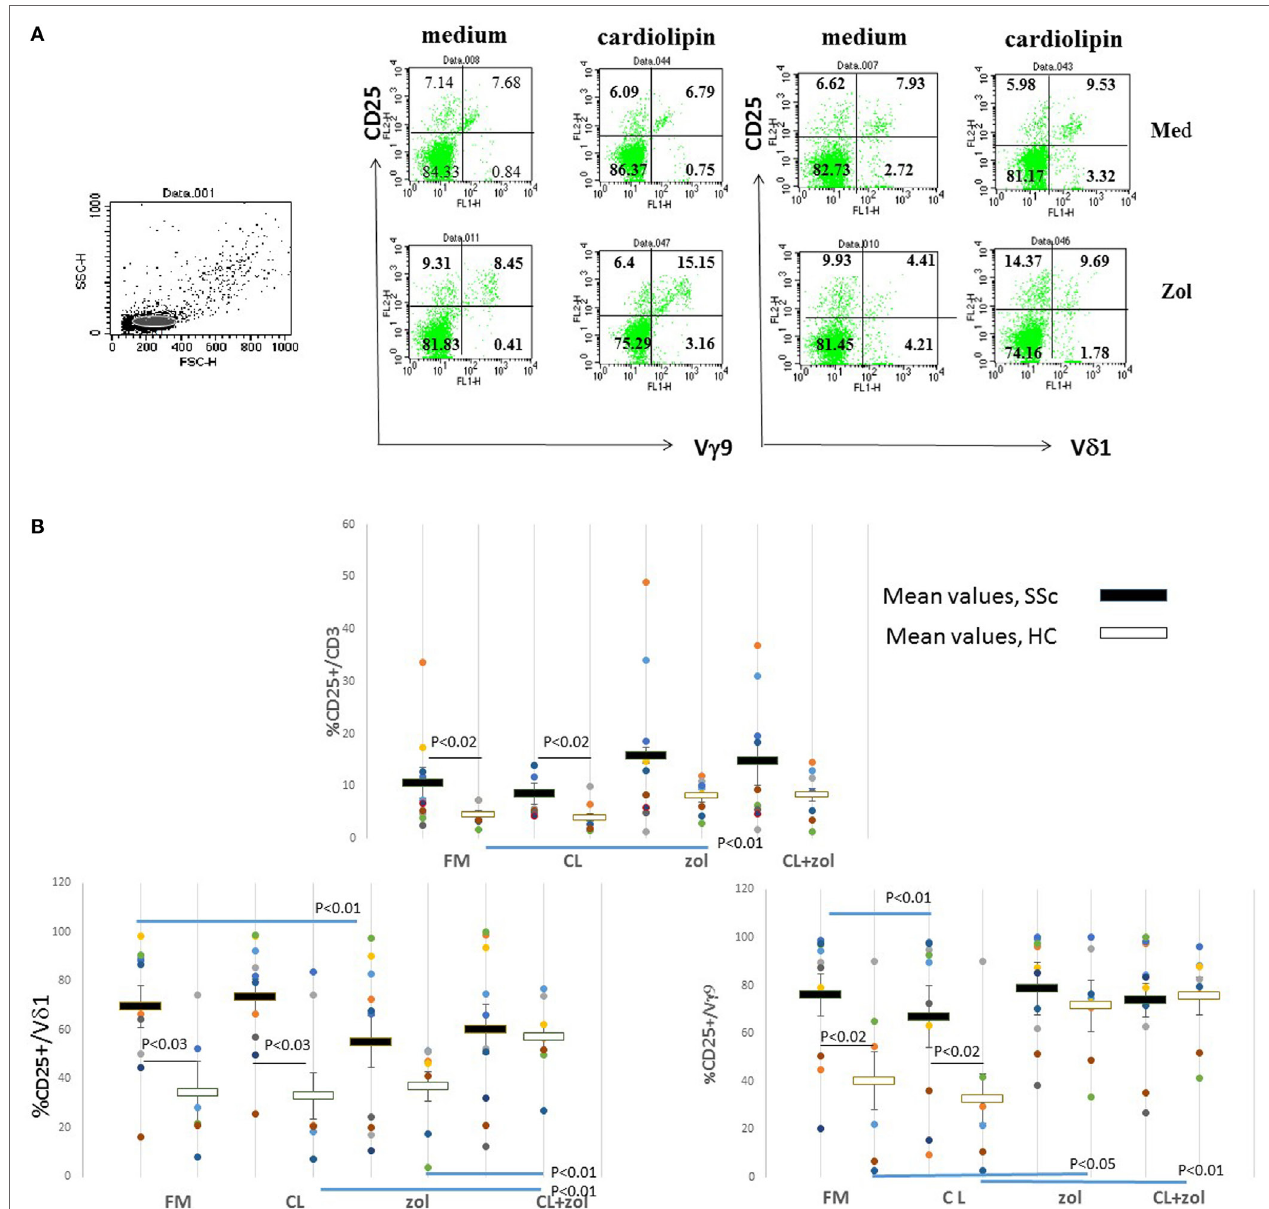
FigUre 2 | CD25 expression on γδ T cells in response to cardiolipin (CL) and zoledronate (zol). (a) Peripheral blood mononuclear cells (PBMCs) from a healthy control (HC) were incubated in medium with interleukin-2 (100 IU) alone or with added CL (2.5 µg/ml), either with or without zol (2 µM) for 4 days and analyzed by flow cytometry after staining with fluorochrome-labeled monoclonal antibodies (mAbs) anti-CD25-PE, anti-V δ 1-FITC, anti-V γ 9-FITC, and anti-CD3-APC. Forward and side scatter of the sampled cells are shown on the left; the lymphocyte population is highlighted in gray. On the right are shown dot plots of cells within total CD3 + population, representing both the CD3 + V δ 1 − (containing most V γ 9 + T cells) and CD3 + V δ 1 + populations after co-staining with mAb to CD25 and either V δ 1 or V γ 9. Percent of cells within indicated quadrants (set on the basis of non-stained cells) are shown. (B) PBMC from 10 systemic sclerosis (SSc; patients 1–10 Table 1 ) and 8 HC were cultured as mentioned in (a) and stained with mAbs to CD25, CD3, V δ 1, and V γ 9. Dots represent values for each culture of an individual. The mean percent and 1 SEM of CD3 + T cells, or of the indicated subsets, expressing CD25 in each of the culture conditions are indicated (medium with IL-2 = FM; medium with CL 2.5 µg/ml with IL-2 = CL; medium with IL-2 and zol 2 μ M = z; zol with CL 2.5 μ g/ml = CL + zol. Black horizontal bars represent mean for SSc and white for HC. P values calculated from two-tailed Student’s t -test comparing groups connected by horizontal lines are